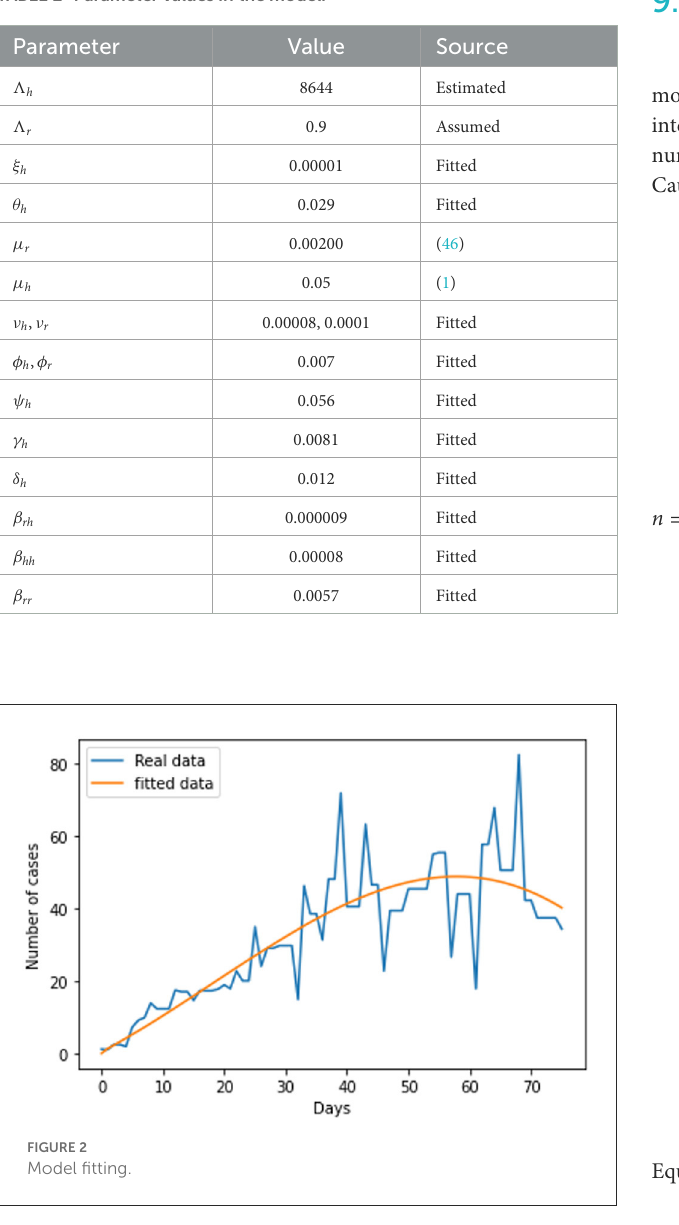
TABLE 2 Parameter values in the model.